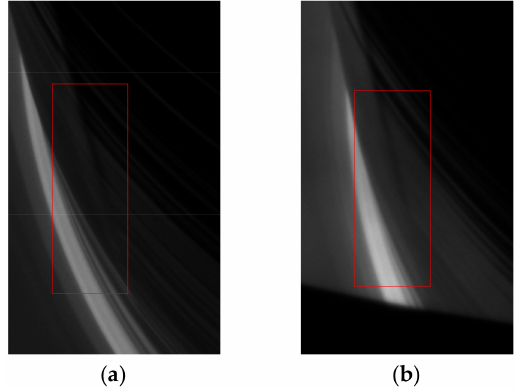
Figure 5. ( a , b ) Di ff erent patterns of disappeared habit